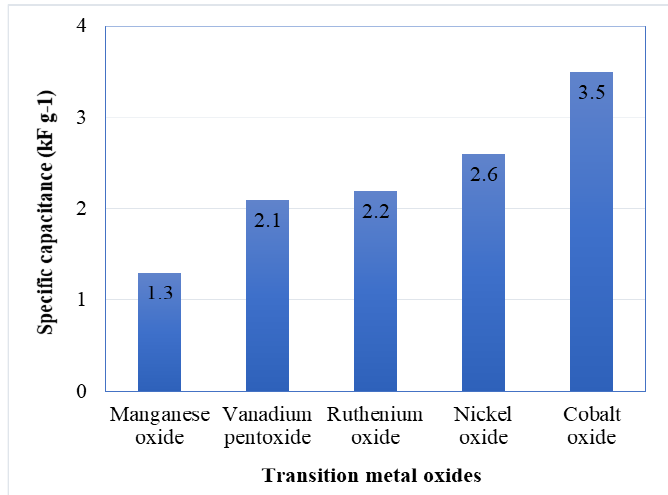
Figure 4. Comparison of the theoretical specific capacitances of different TMOs.